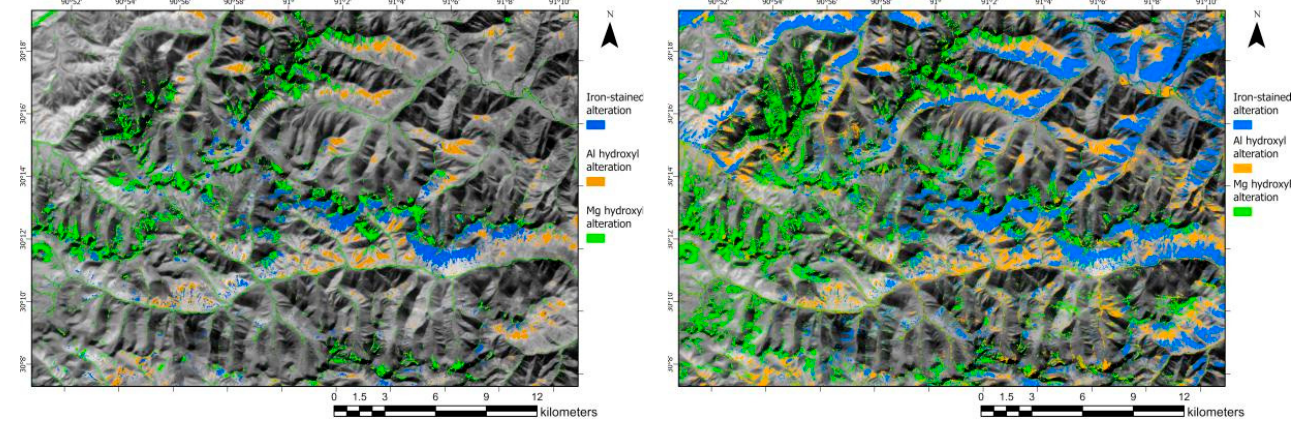
Figure 4. Comparison of the results of the traditional Crosta method ( left ) and the EPCA method ( right ) for extracting change information in selected areas of the study area.